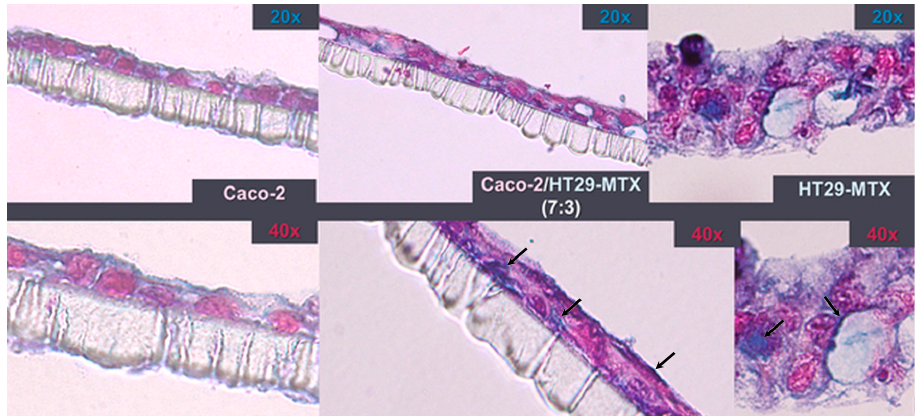
Figure 5. Insert cross-sections after 21 days in culture. Staining with 1% Alcian Blue highlights the production of mucins (black arrows) by HT29-MTX cells. The monolayers were counterstained with 0.1% eosin.